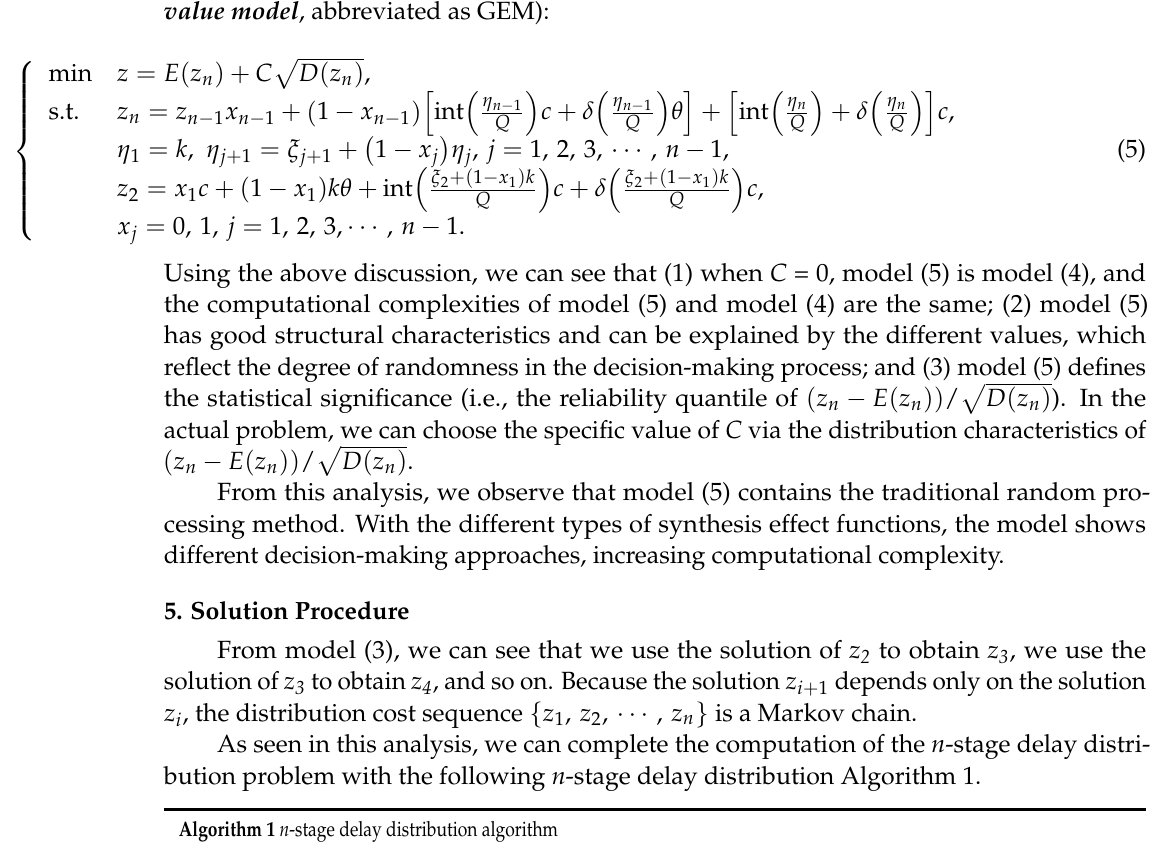
Algorithm 1 n -stage delay distribution